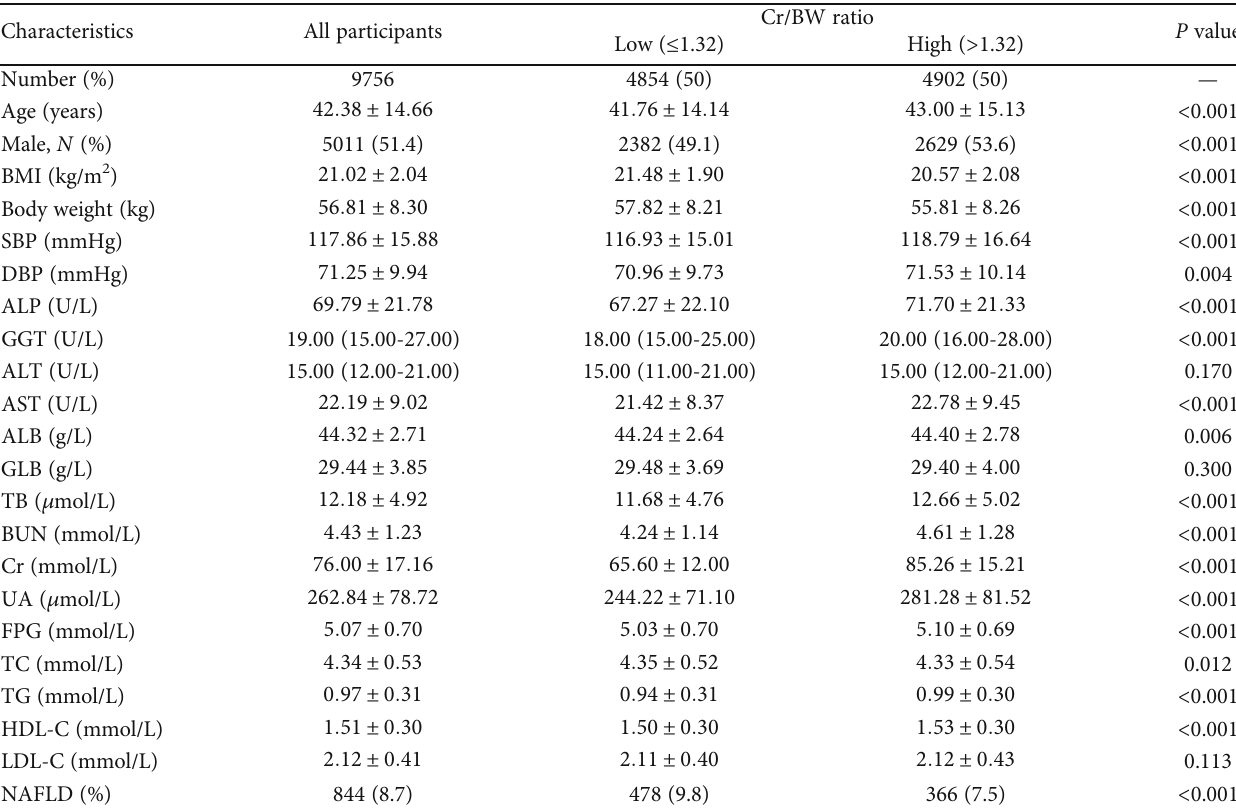
Table 1: Baseline characteristics of 9756